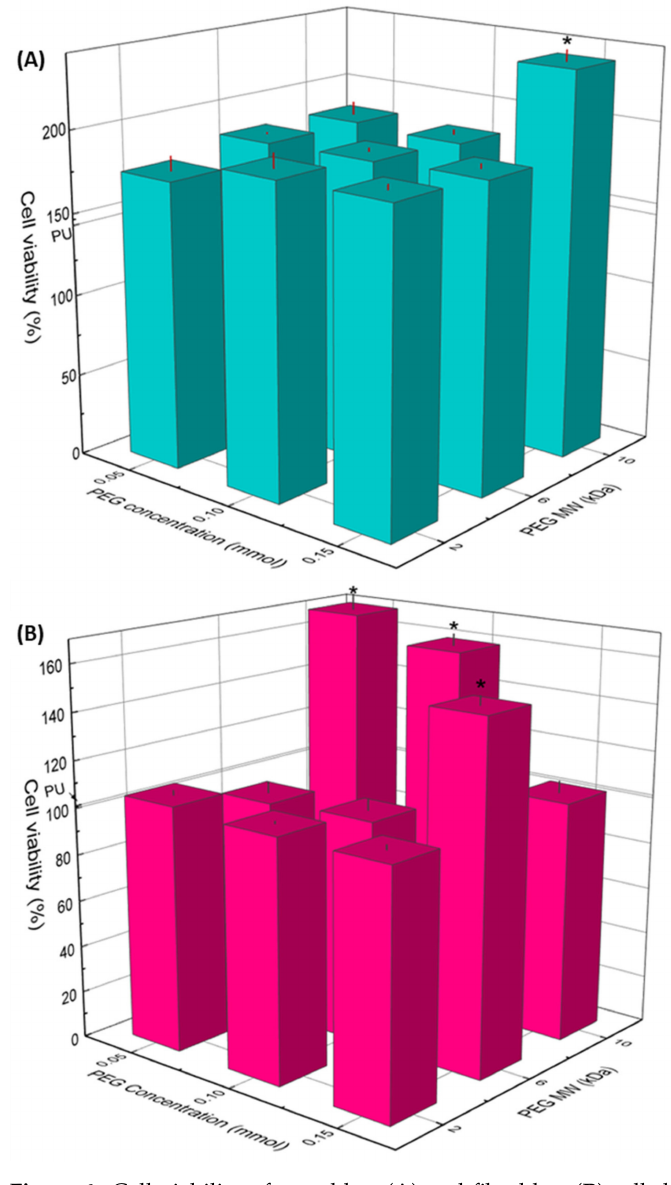
Figure 6. Cell viability of osteoblast ( A ) and fibroblast ( B ) cells by indirect contact with PU and PEG-grafted substrata for 24 h. (*): Statistical difference ( p <